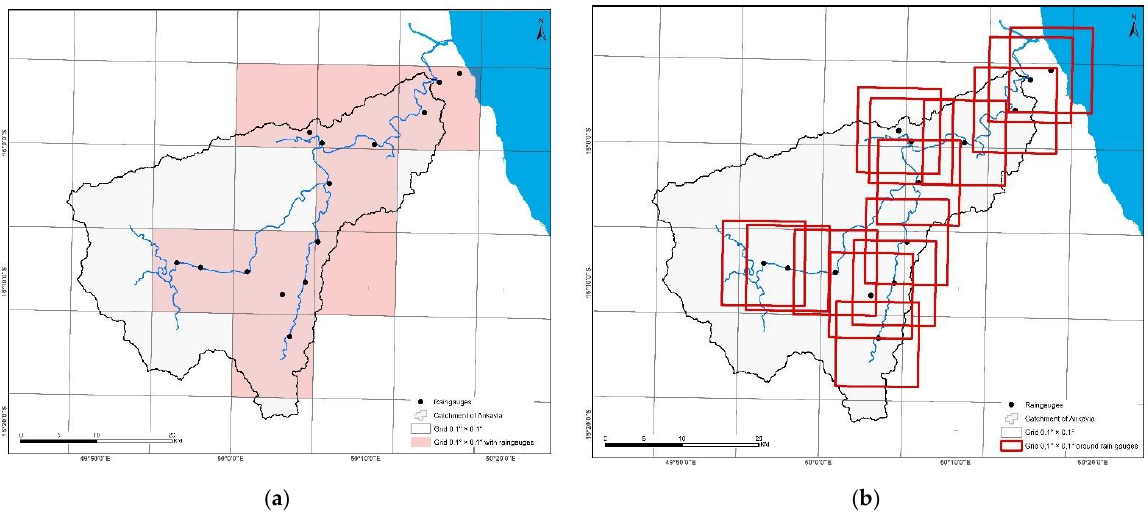
Figure 2. Data processing with two different approaches: ( a ) point-to-grid, ( b ) point-gridded.